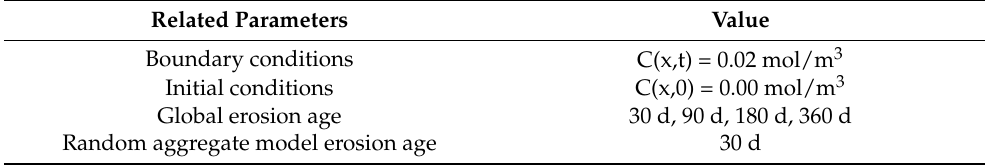
Table 8. Parameters related to chloride diffusion.